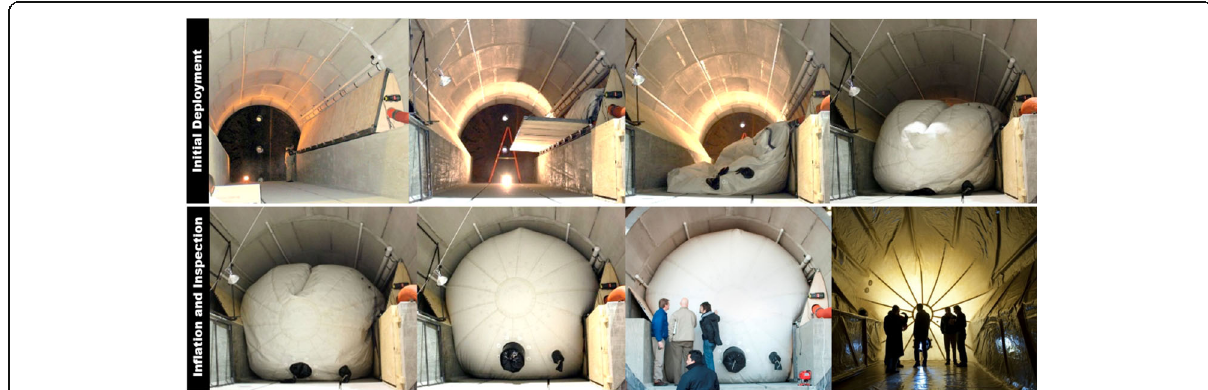
Fig. 4 Phase 2, full-scale testing, single layer surrogate plug: Sequence of initial deployment, inflation, and external and internal